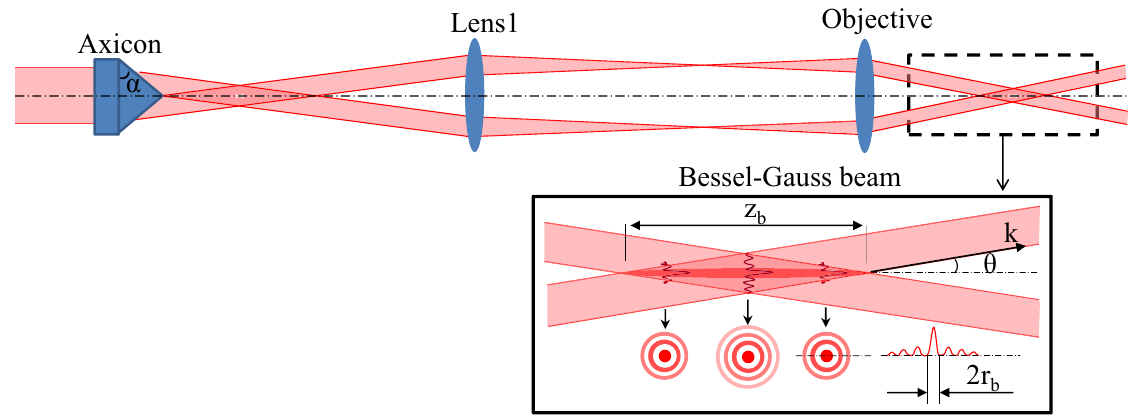
Figure 9. Schematic of the Bessel-Gaussian beam configuration, including an axicon and a standard 4f telescopic system (an achromatic lens and a microscope objective). The inset describes standard parameters of the Bessel beam with D 0 is the incident Gaussian beam diameter, α is the physical or base angle of the axicon, Z b is the Bessel length, θ is the half cone angle, k is the wave vector, and 2 r b is the diameter of the beam central